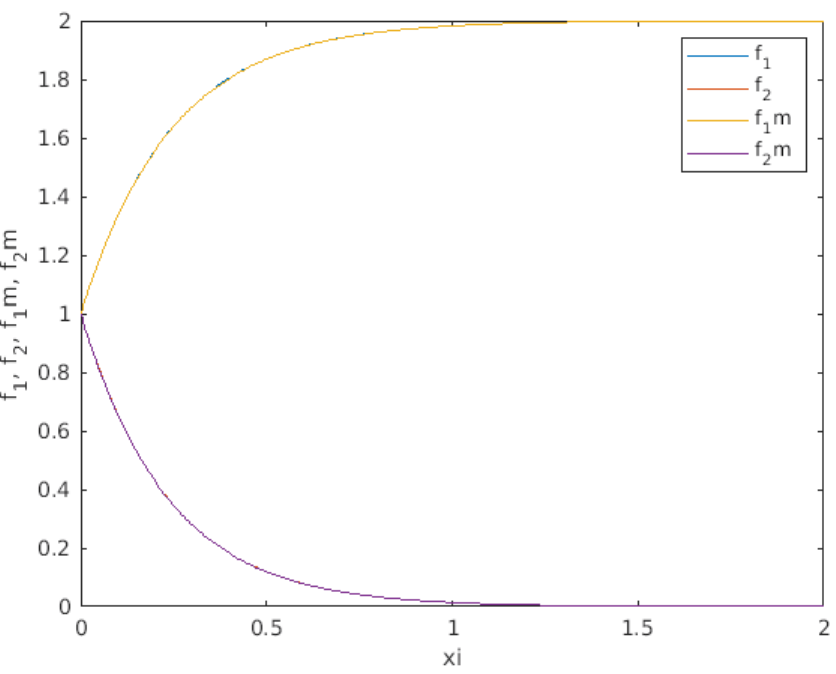
Figure 1. TW profiles for a + λ = 4 with n = 0.9, m = 0.1. For the sake of simplicity, r = 2. The numerical exercise was performed for an integration interval ( 0,100 ) ; nonetheless, the interval was cut for representation purposes. Note that f 1 and f 2 represent ϕ 1 and ϕ 2 solutions to (19) while f 1 m and f 2 m are solutions to (20) . .